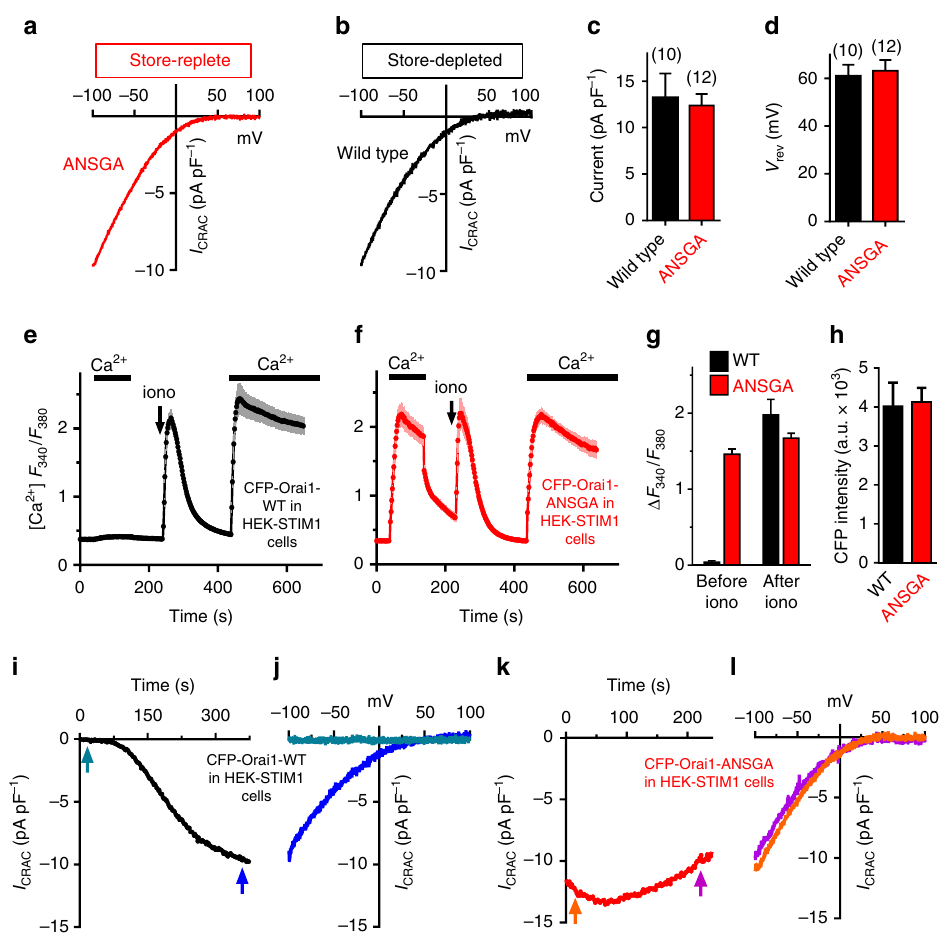
Figure 2 | The Orai1-ANSGA mutant is fully active and independent of STIM1. ( a ) I – V relationship in store-replete HEK cells expressing CFP-Orai1- ANSGA. ( b ) I – V relationship in store-depleted HEK cells expressing CFP-Orai1-WT and STIM1-YFP. ( c ) Summary of the peak current amplitude at (cid:2) 100mV. ( d ) Summary of the reversal potential measured from I – V data for Orai1-WTactivated by store depletion and constitutively active Orai1-ANSGA in store-replete cells. ( e , f ) Fura-2 Ca 2 þ responses in stable HEK-STIM1-YFP cells expressing CFP-Orai1-WT ( e ) or CFP-Orai1-ANSGA ( f ) before and after store depletion with 2.5 m M ionomycin. ( g ) Summary of the constitutive (before ionomycin) and store-dependent (after ionomycin) Ca 2 þ entry in cells shown in e , f . ( h ) CFP fluorescence intensity of cells in e , f . ( i , j ) Internal BAPTA dialysis to deplete stores caused I CRAC to develop over time in HEK-STIM1- YFP cells expressing CFP-Orai1-WT. ( k , l ) With identical BAPTA-treated HEK-STIM1-YFP cells expressing CFP-Orai1-ANSGA, maximal I CRAC was observed at break-in. I – V curves ( j , l ) were determined at arrows shown ( i , k ). All values are means ±